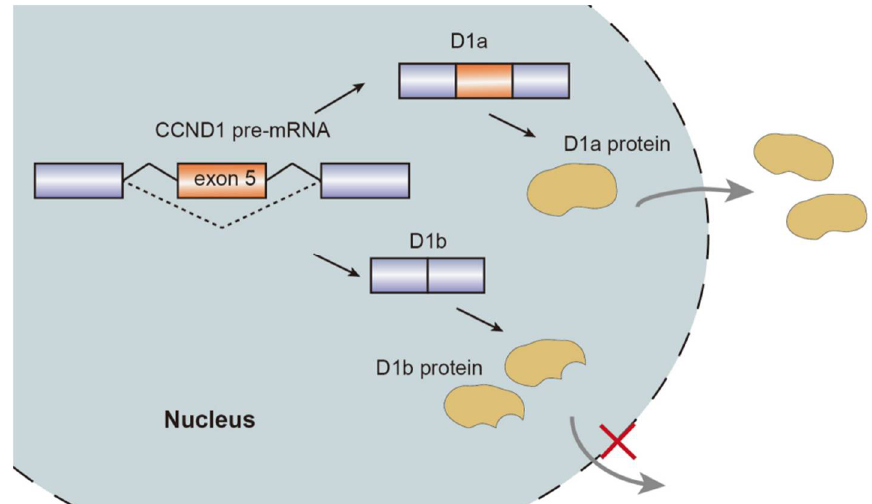
Figure 2. Schematic representation of CCND1 pre-mRNA splicing mechanism, isoforms, and nuclear transport.